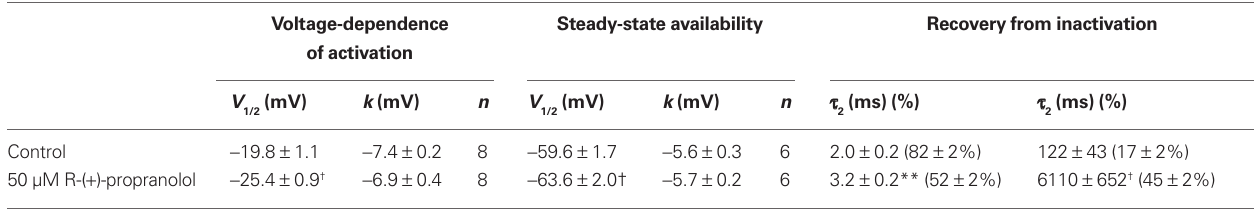
channel availability (“steady-state inactivation”) in the absence and presence Figure 9 | Biophysical effects of r-(+)-propranolol on Na 1.1. (A) V of drug measured using a two-pulse protocol illustrated in the inset. Current–voltage relationships in the absence and presence of 50 μM (D) Effect of R-( + )-propranolol on recovery from inactivation (holding potential R-( + )-propranolol. Peak current amplitudes were elicited from a holding potential of − 120 mV to various test potentials then normalized to cell − 120 mV). Fit parameters for data in (B–D) are provided in Table 3 , and lines in (B,C) represent Boltzmann fits. Each point represents mean ± SEM from capacitance. (B) Conductance–voltage relationship in the absence and 6 to 8 cells. presence of 50 μM R-( + )-propranolol. (C) Voltage-dependence of sodium Table 3 | effects of r-( + )-propranolol on Na 1.1 biophysical properties. V